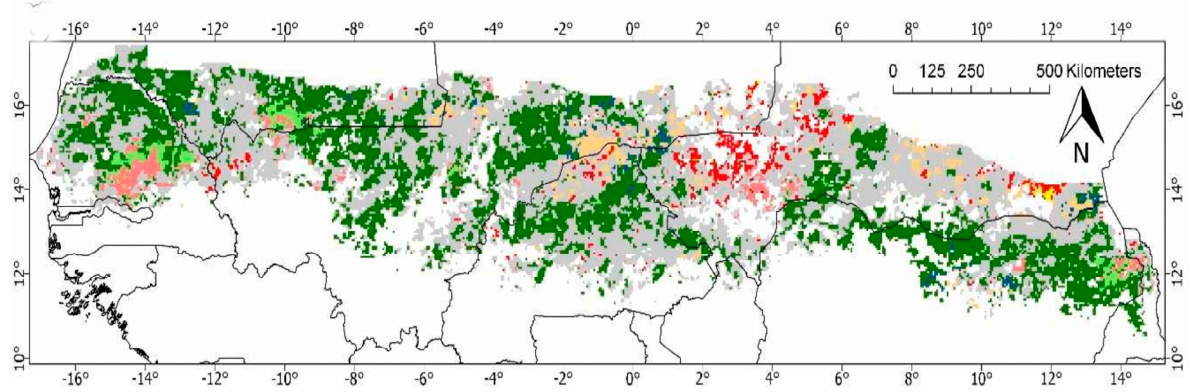
Figure 6. Considered landscape from the data source.